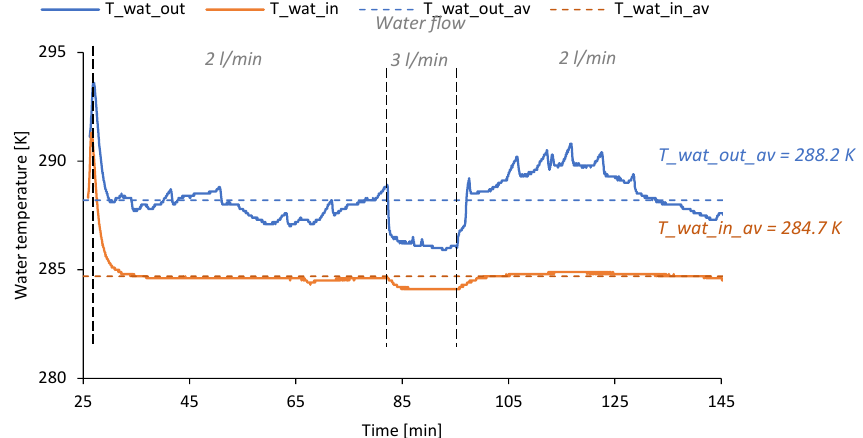
Figure 9. Variations in the temperature of water at the outlet from the TEG ( T_wat_out ) and water at the inlet to the TEG ( T_wat_in ).